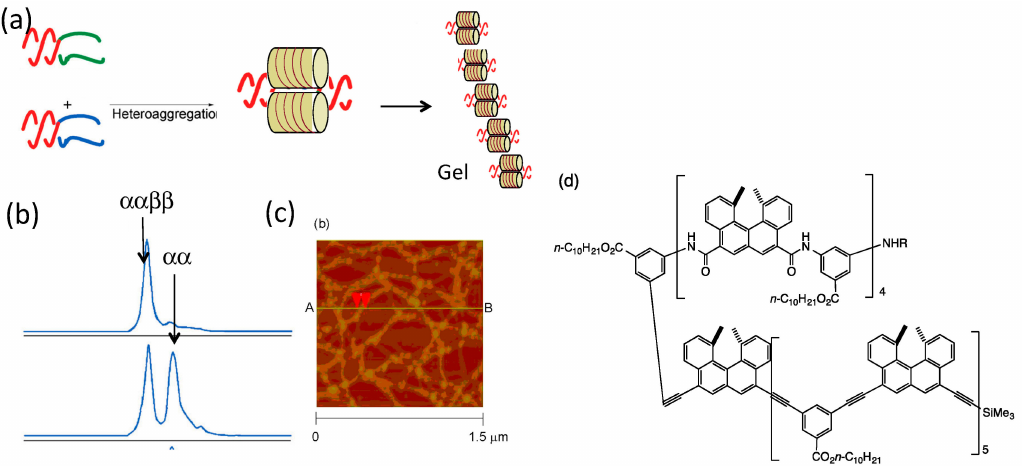
Figure 23. Formation of ααββ tetrameric aggregates derived from bi-domain ( P , P )- and ( P , M )-compounds ( a ); HPLC profiles ( b ) and AFM images ( c ) of gels are shown. Chemical structure of bi-domain ( P , P )-oligomer is also shown ( d